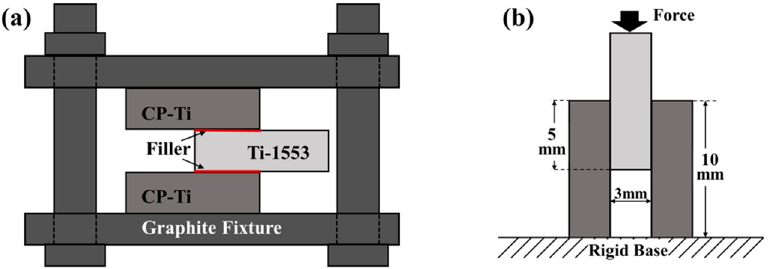
Figure 1. Schematic diagrams of ( a ) double lap joints, ( b ) the dimensions of the sample for the shear test.